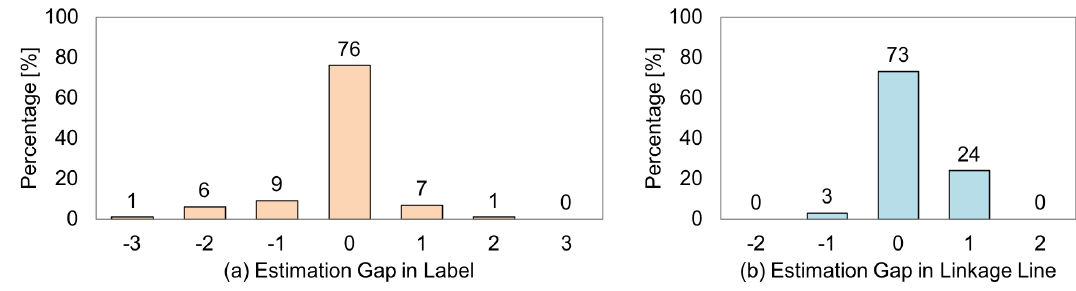
Figure 13. The distribution of gaps between the participant’s evaluation and the system’s estimation.